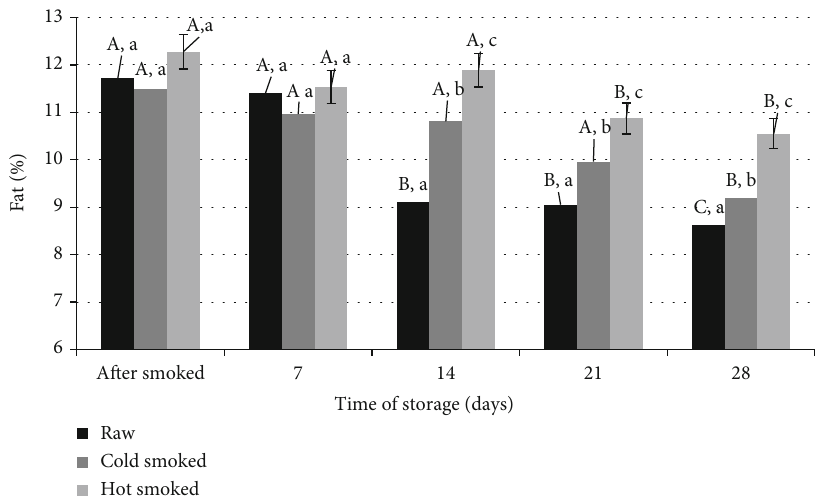
Figure 1: Comparison of changes in fat content during storage of raw, cold-smoked, and hot-smoked salmon. a, b, c: signi fi cant di ff erences ( n = 3 ) between individual treatments within one storage time. A, B, C: signi fi cant di ff erences ( n = 3 ) between processing methods during storage. Table 1: Changes in physicochemical parameters in raw salmon after cold and hot